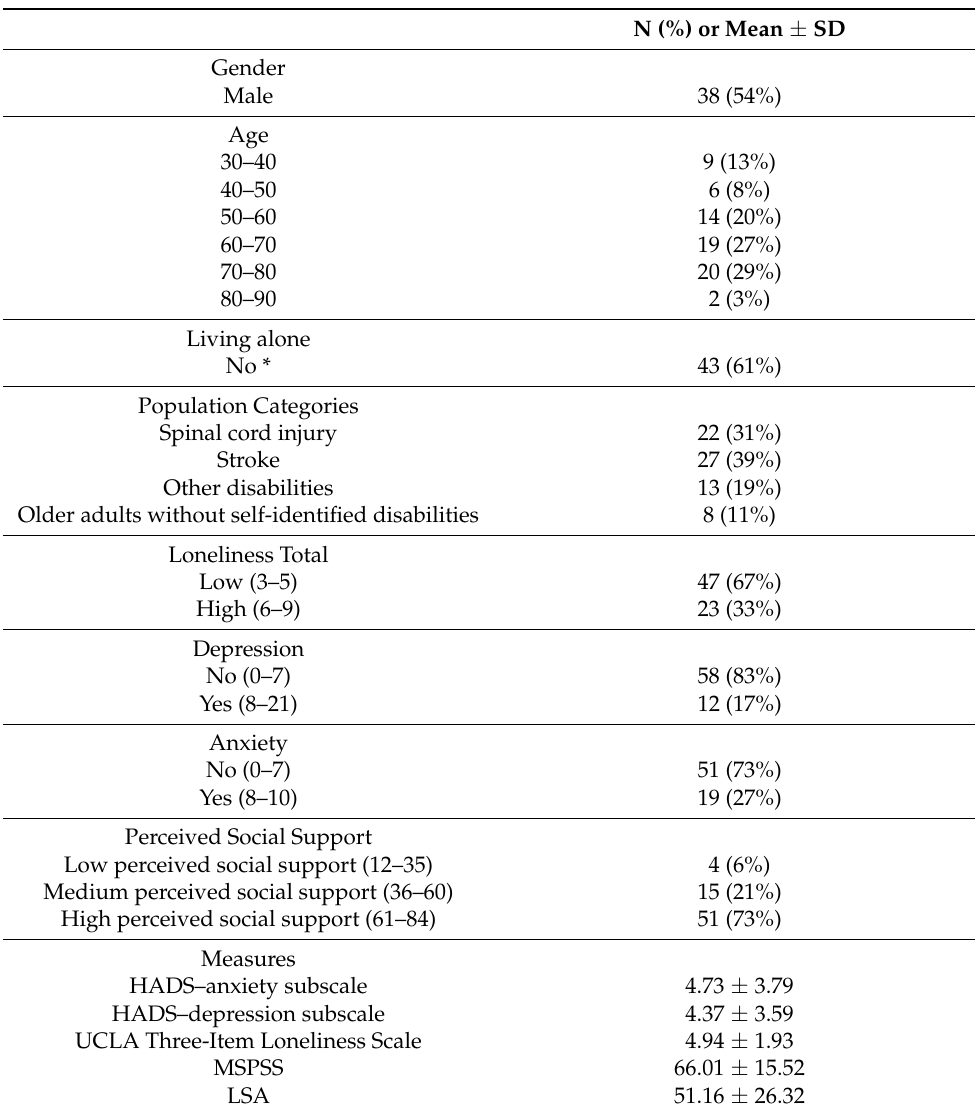
Table 1. Descriptive statistics and the distribution of psychosocial factor